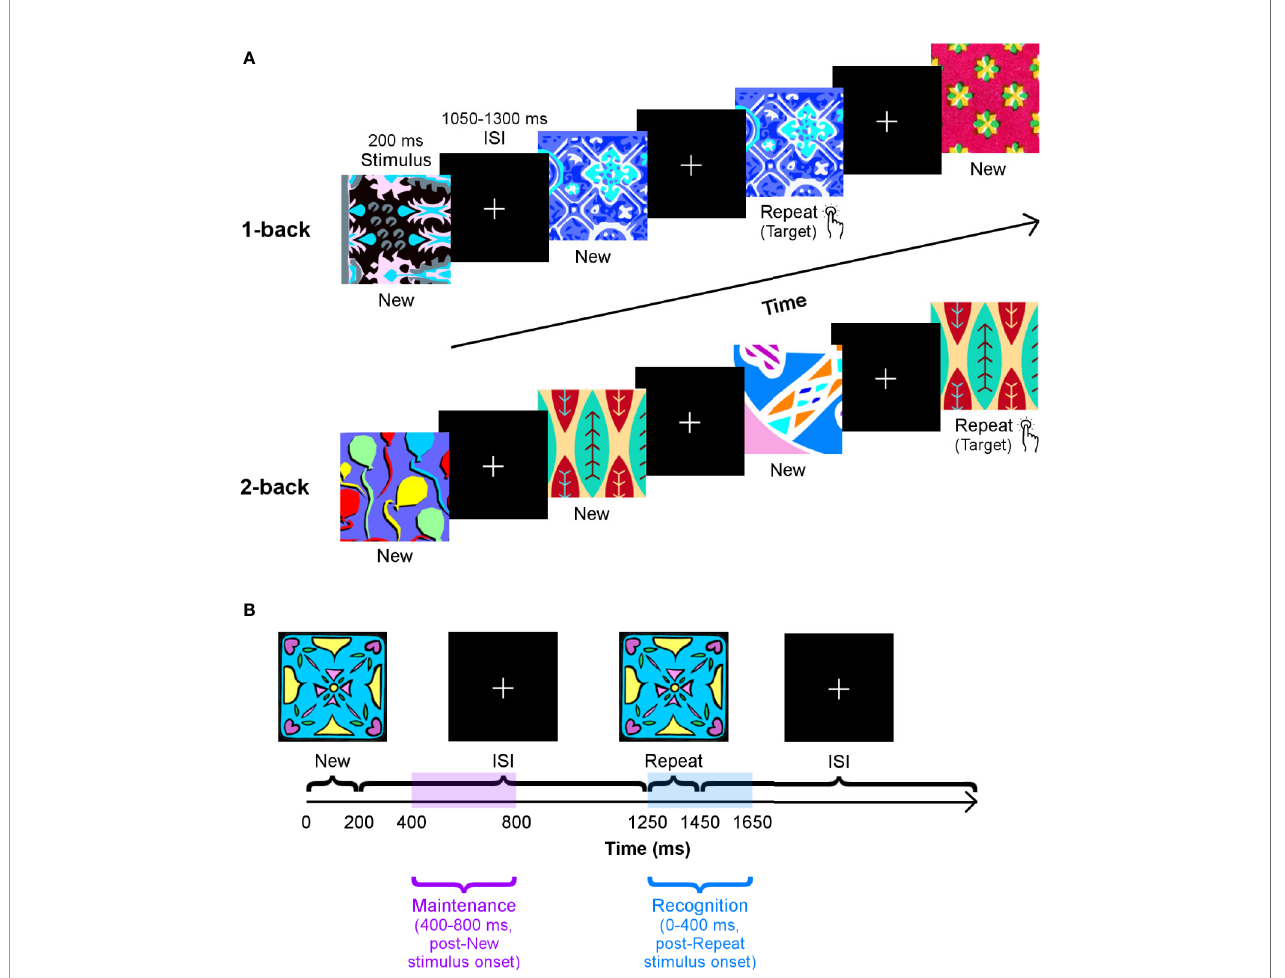
FIGURE 1 | The n -back task. (A) Participants ’ performance on two loads of this task — 1-back (top row) and 2-back (bottom row) — were tested in separate blocks. They were instructed to press a button as quickly as possible when they recognised that a stimulus had been repeated one or two trials earlier. Images were presented for 200 ms, and the interstimulus interval varied between 1,050 – 1,300 ms. (B) A schematic of the time windows used to analyse working memory maintenance and recognition processes, with the 1-back load as an